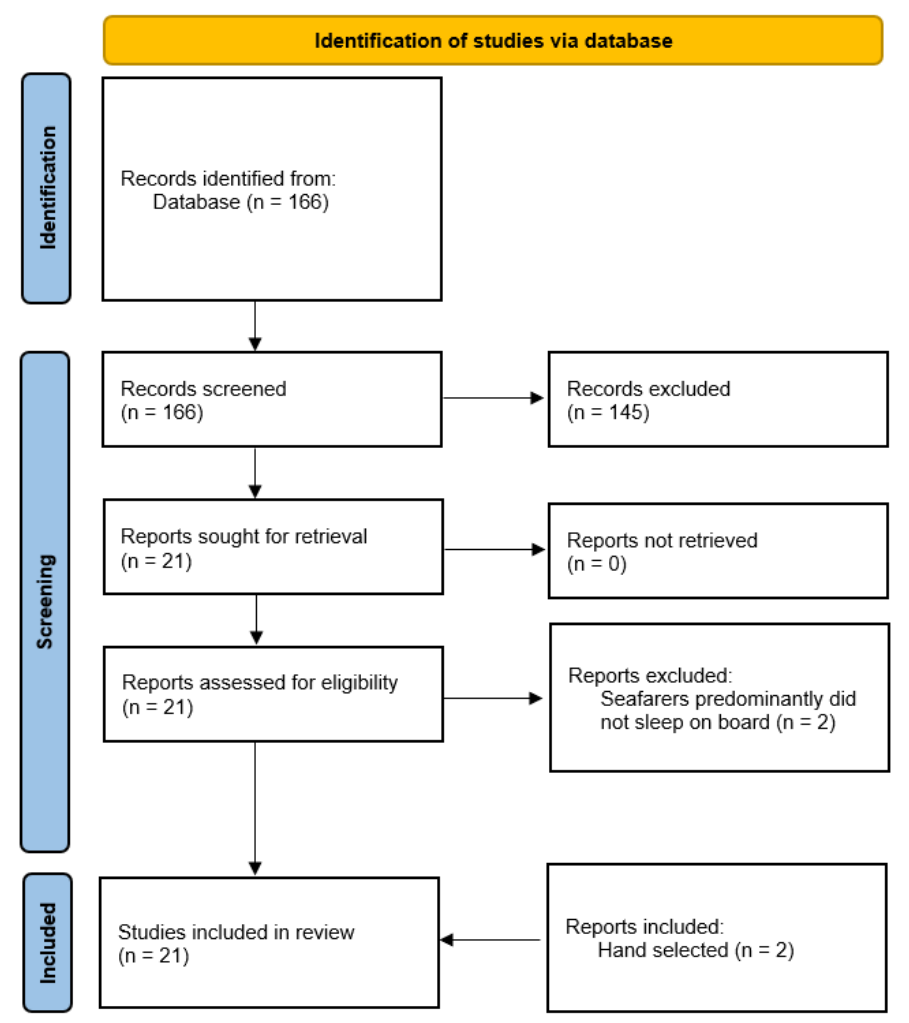
Figure 1. Search strategy on maritime studies of fatigue, sleepiness, and sleep behaviour following the PRISMA statement.